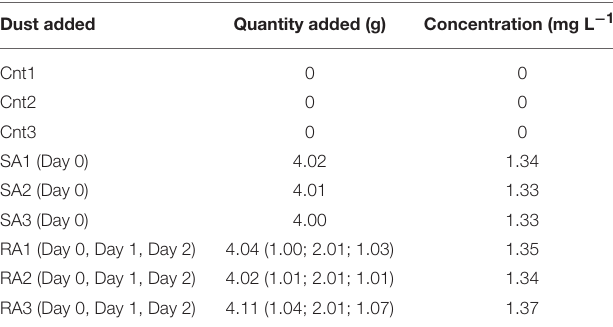
TABLE 1 | Quantity and concentration of dust added to mesocosms, in SA (Day 0) and RA (Days 0, 1, 2). Dust